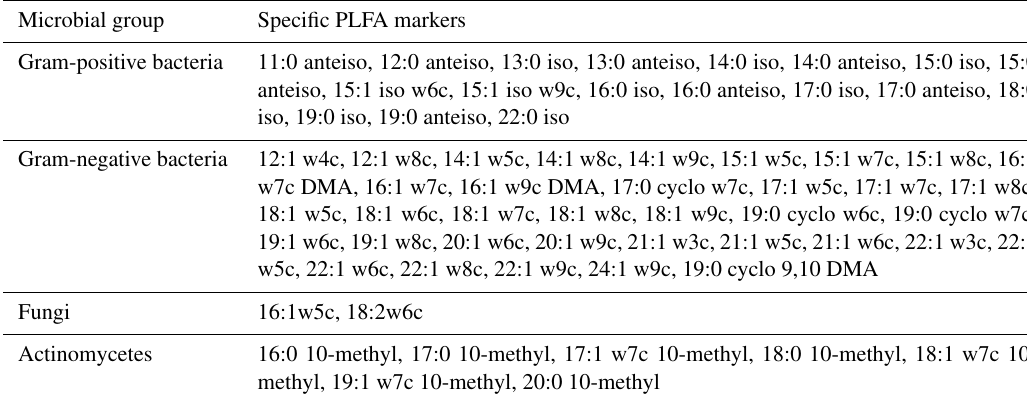
Table 2. Characterization of the microbial phospholipid fatty acids. Microbial group Specific PLFA